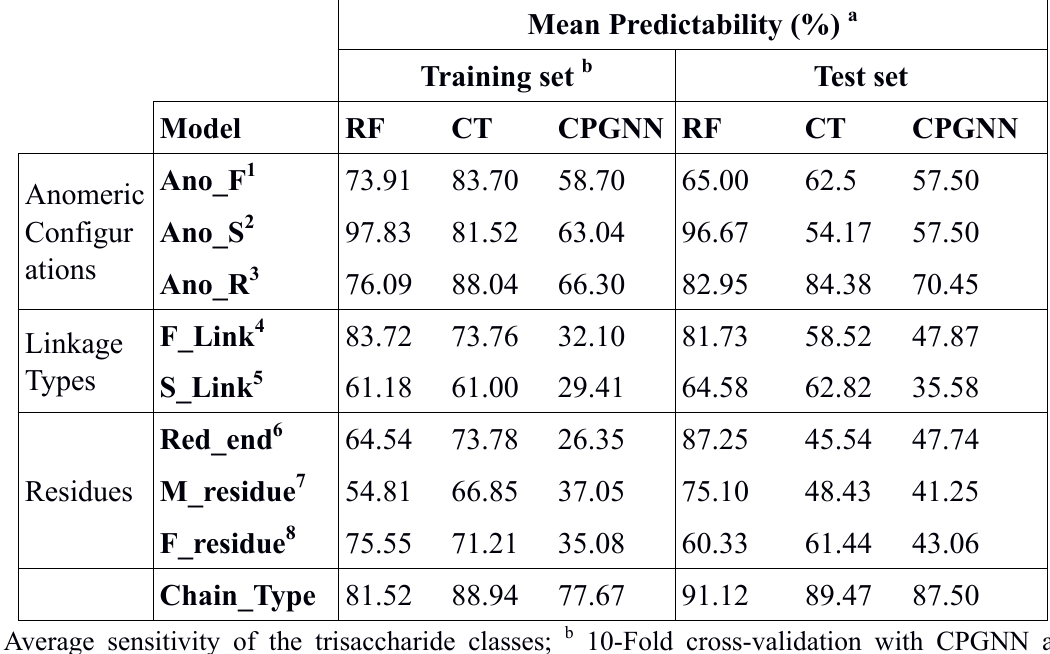
Table 2. Mean predictability of RF, CT and CPGNN predictions of the anomeric configurations, type of linkages, residues and chain type in trisaccharides from 1D 13